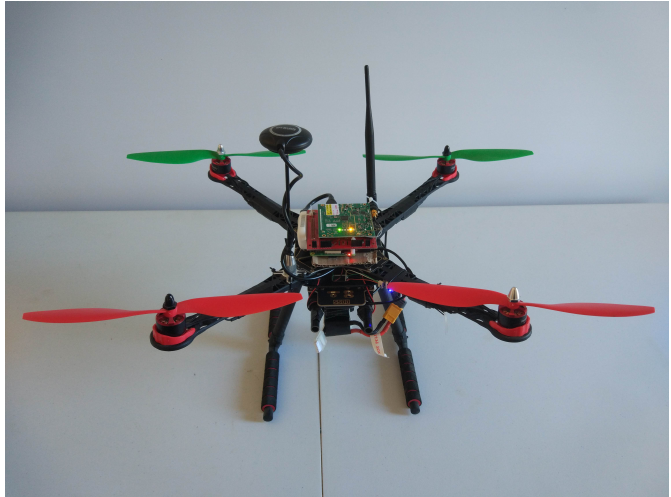
Figure 2. LoRa-drone gateway implementation used for testing.